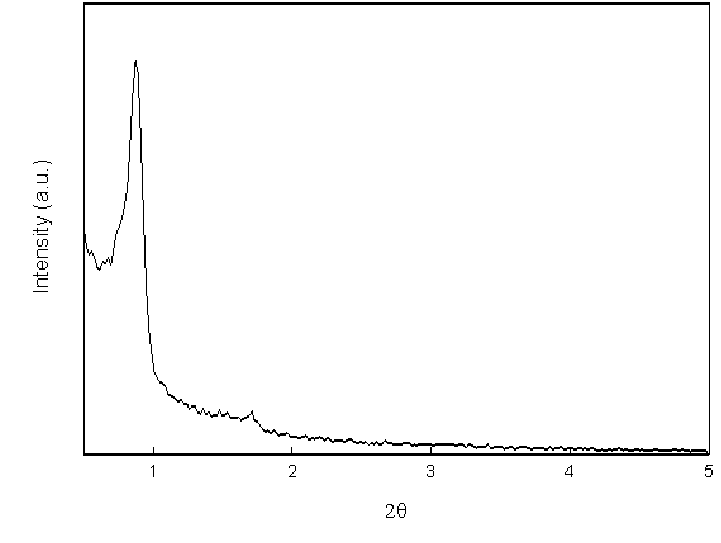
Figure 5. XRD pattern of Cu ‐ L@SBA ‐ 15 .